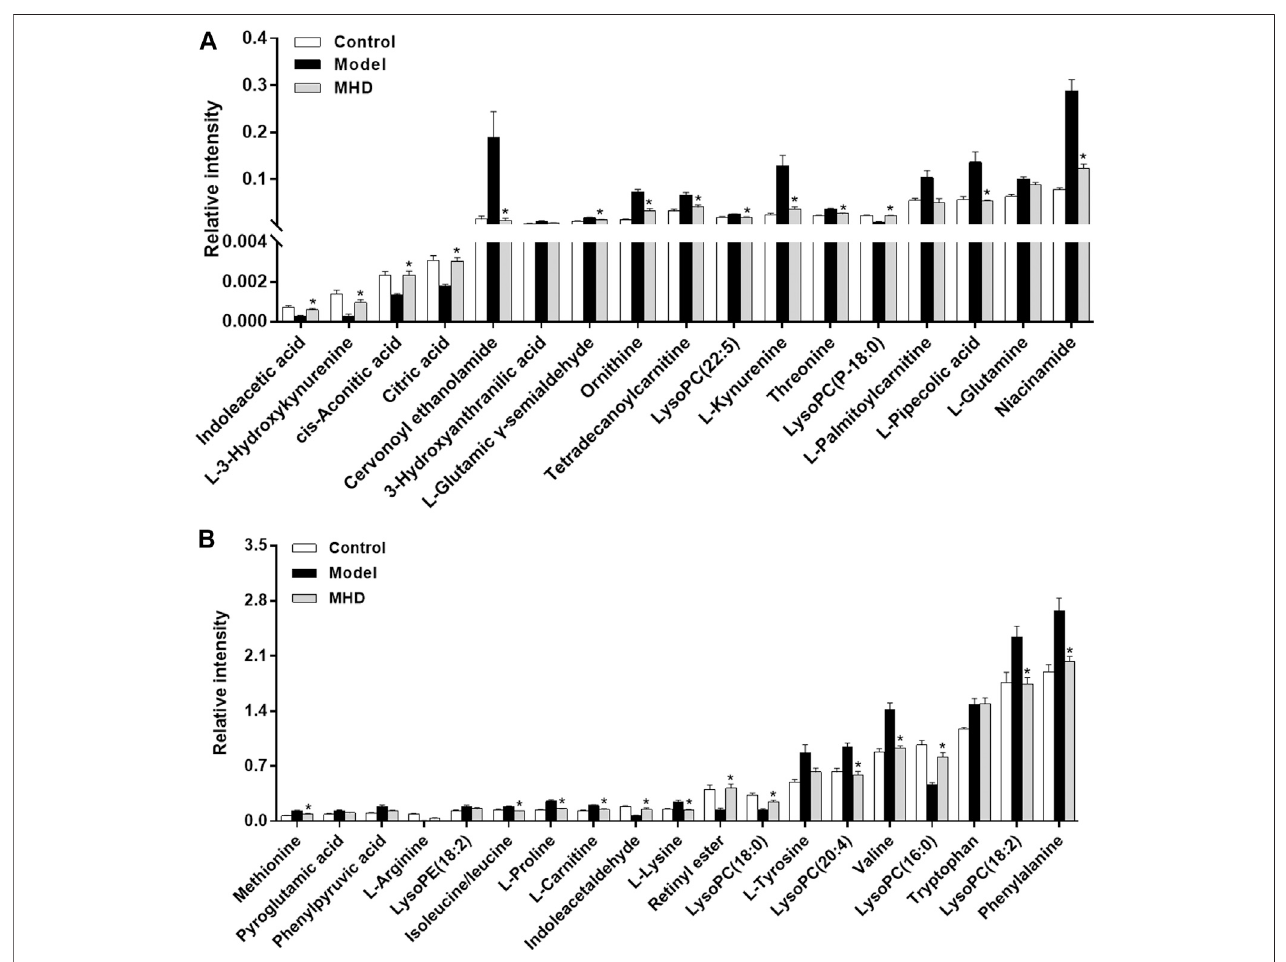
FIGURE 5 | Changes in the relative intensity of target metabolites. Statistical signi fi cance was performed using univariate statistical analysis. 27 metabolites were signi fi cantly reversed by MHD. Values are shown in Mean ± SEM. * p < 0.05 vs. model group.